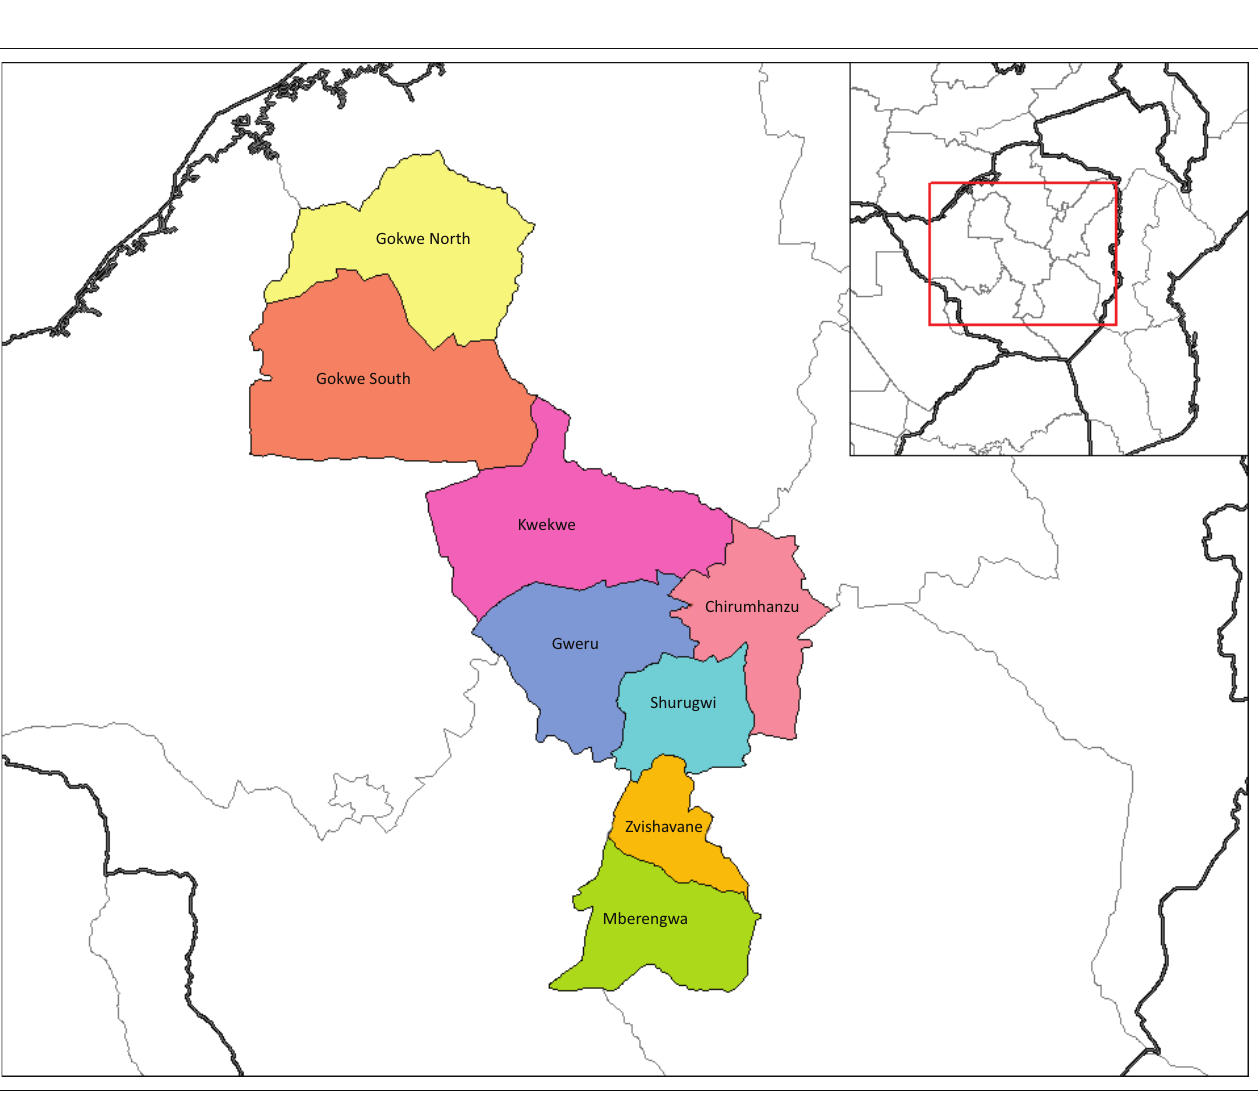
FIGURE 1: Map of Shurugwi District in the Midlands Province of